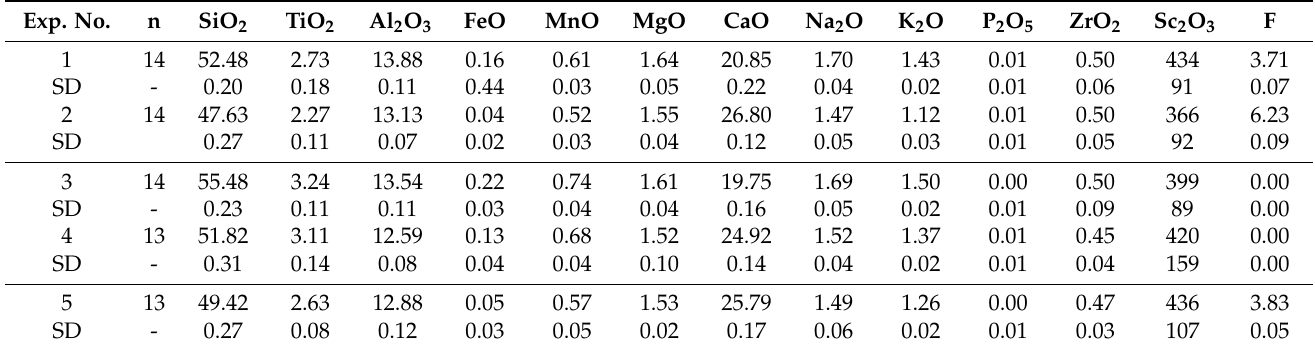
According to the EPMA data (provided in electronic supplementary Table S2), CaF 2 addition promoted the reduction of SiO 2 and solution of silicon to ferrite. None of the metal analyses provided Sc contents above the detection limit (100 ppm Sc). Titanium carbide (TiC) formation was occasionally observed on the borders of graphite and ferrite. Metal analyses did not indicate the presence of Fe 3 C. Figure 4 presents an overview of the characteristics of large metal accumulation after the experiment with 10% addition of CaO, with a close-up of the texture and EPMA point analytical data. The black areas in the back-scattered electron images represent graphite and the brightest phase is ferrite while the intermediate grey color represents steadite, the eutectic of ferrite and iron phosphide (Fe 3 P). It solidifies during cooling from the liquid as the last constituent at the grain boundaries